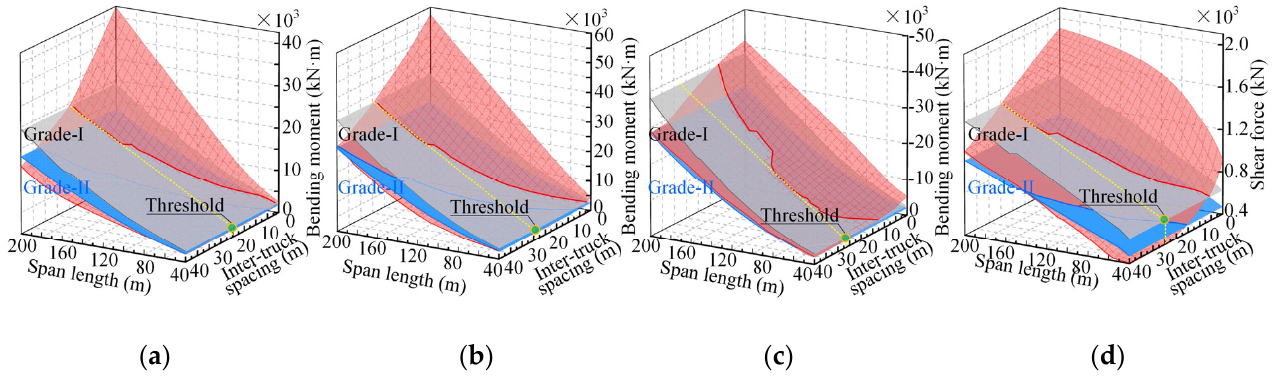
Figure 11. Load effects of continuous bridges due to four-truck (55 t) ATP loads: ( a ) bending moment at middle section of the side span; ( b ) bending moment at middle section of the main span; ( c ) negative bending moment at the interior support; ( d ) shear forces at the interior support.